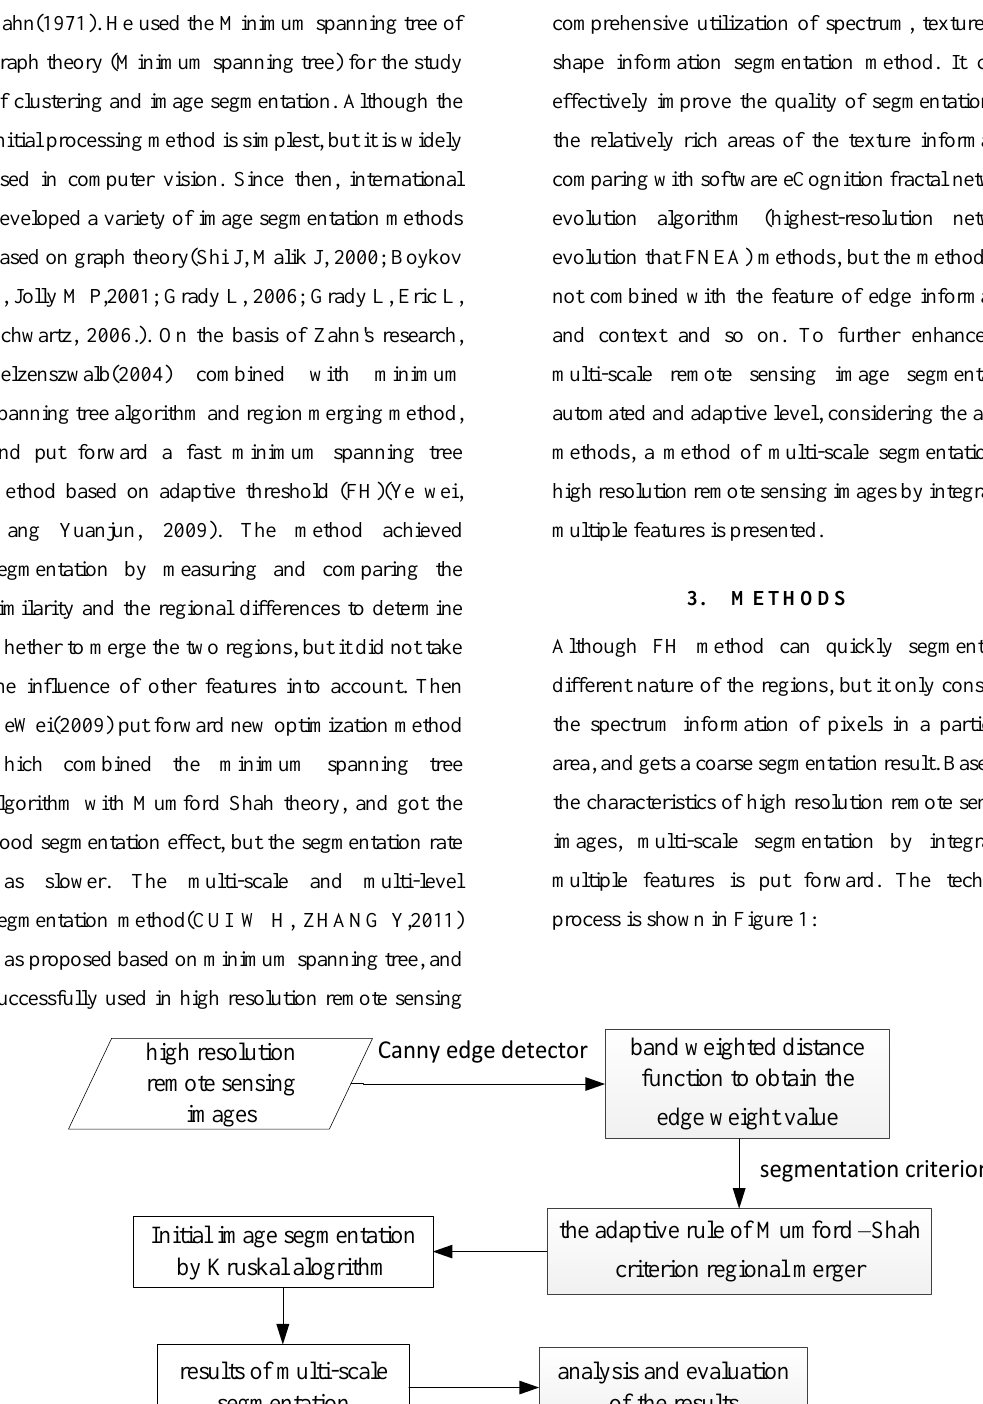
3.1 edge extraction by Canny